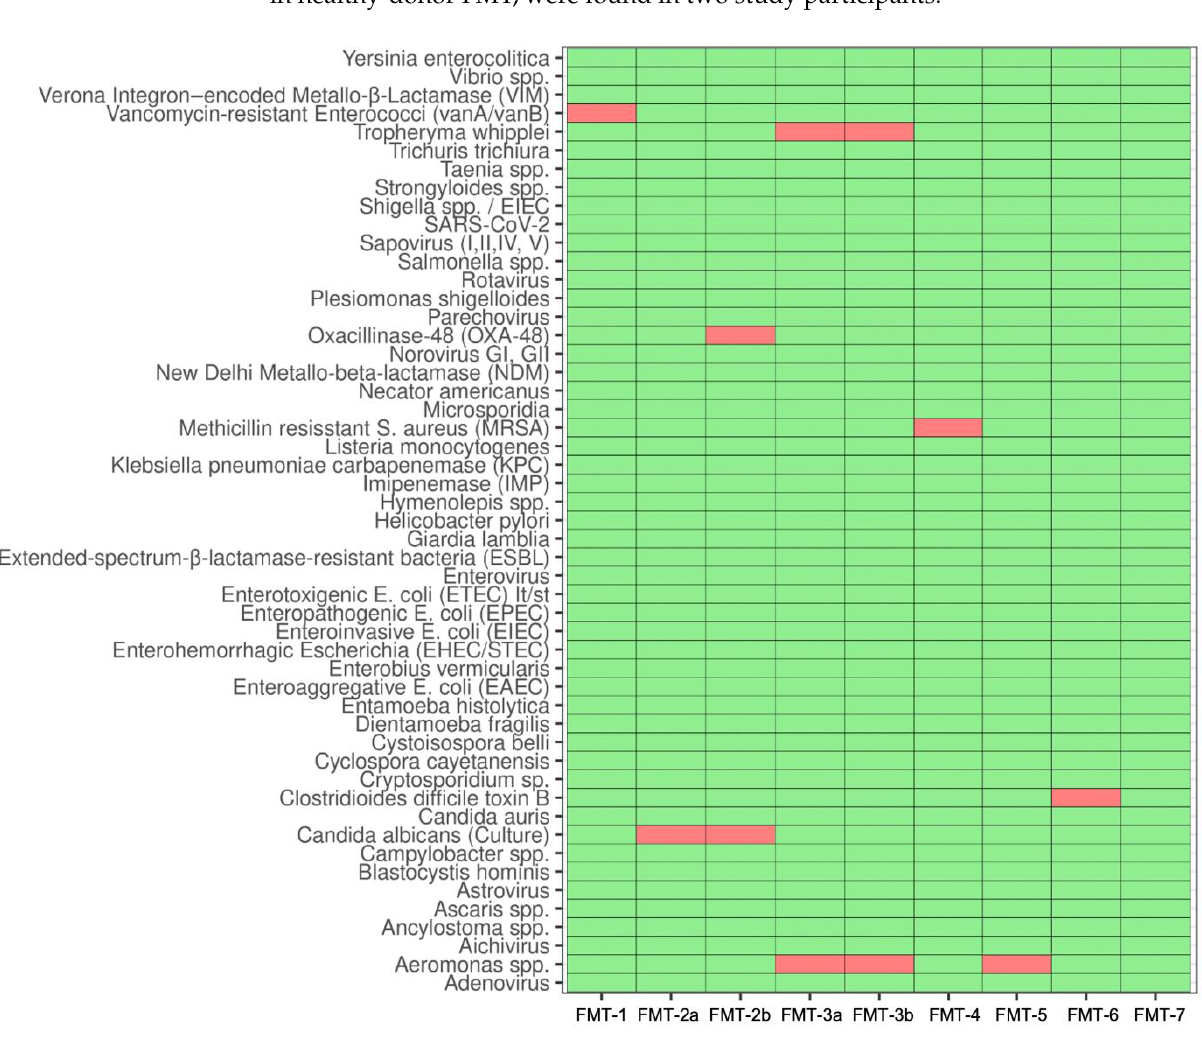
Figure 3. Results from infectious disease safety screening. In-depth FMT donor screening was performed on stool samples from the seven study participants. Red boxes indicate detection of the respective pathogen. Patients FMT-2 and FMT-3 provided fecal material for two test runs (FMT2a/b and FMT-3a/b).